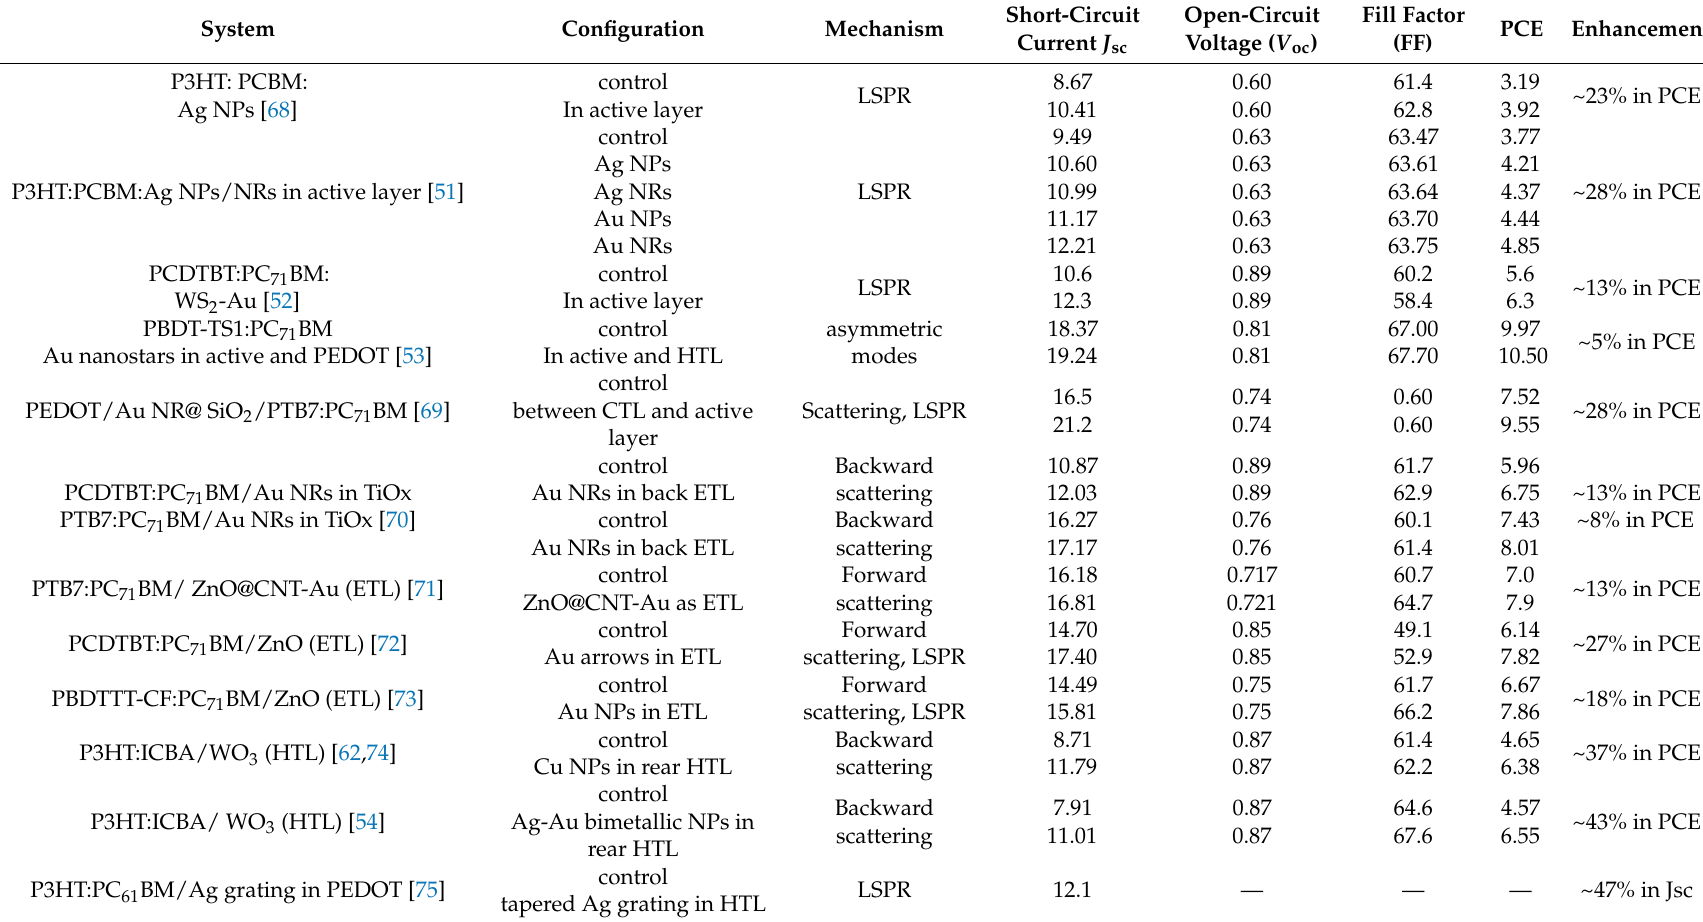
Table 1. Performance of OPV solar cells with various nanostructures at different